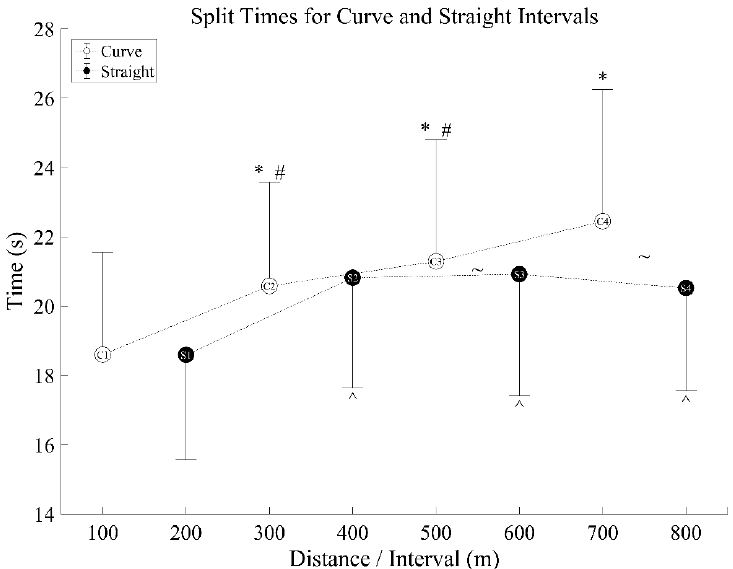
Figure 3. Split times for curve and straight intervals—mean (circles) ± standard deviation bar (vertical bars-shown in one direction only). C1 signifies ‘Curve 1’, S1 signifies ‘Straight 1.’ *—significantly different from C1; #—significantly different from C4; ˆ—significantly different from S1; ~—significant difference between C3 and S3, and C4 and S4.